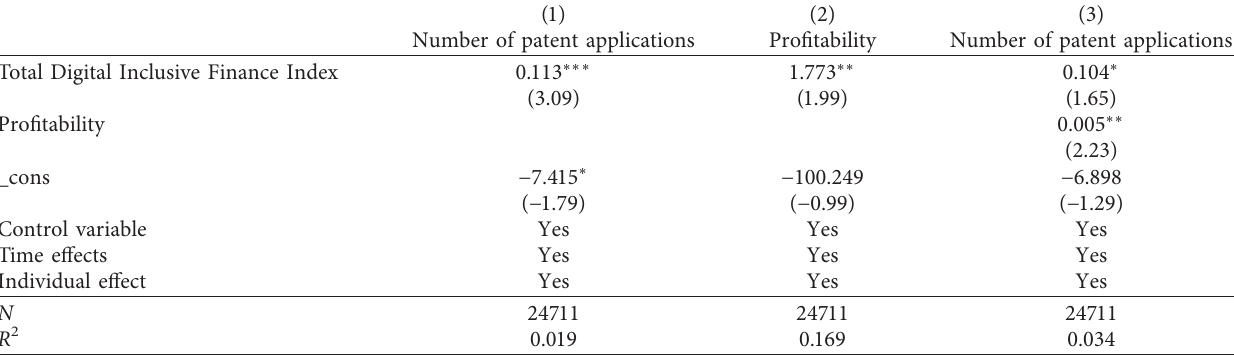
Table 6: Intermediary mechanisms,